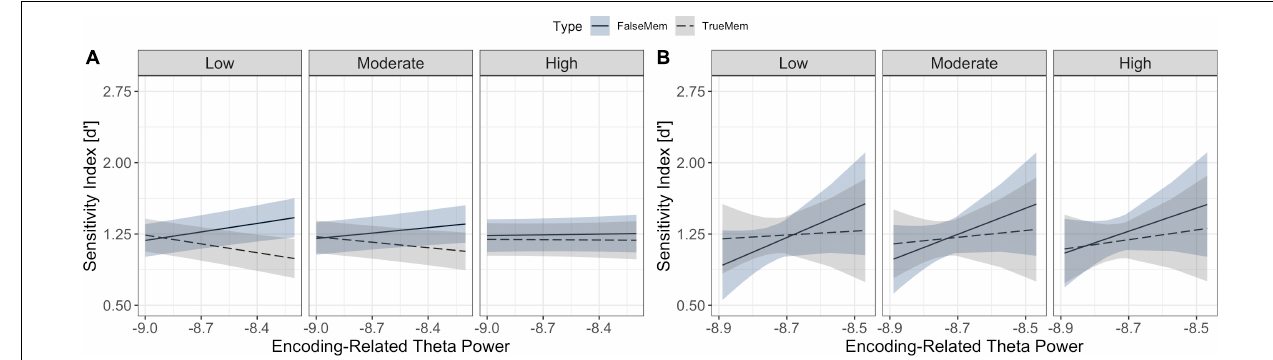
FIGURE 5 | Relationships between sleep microstate variables and memory for list words and associative lures. (A) Interaction between theta power at encoding (x-axis), memory type (association in blue, veridical in grey), and sleep spindle density (facets) in predicting d’ (y-axis); (B) Interaction between theta power at encoding (x-axis), memory type (association in blue, veridical in grey), and sleep spindle-slow oscillation coupling strength (facets) in predicting d’ performance (y-axis). Ribbons indicate the 83% confidence interval.